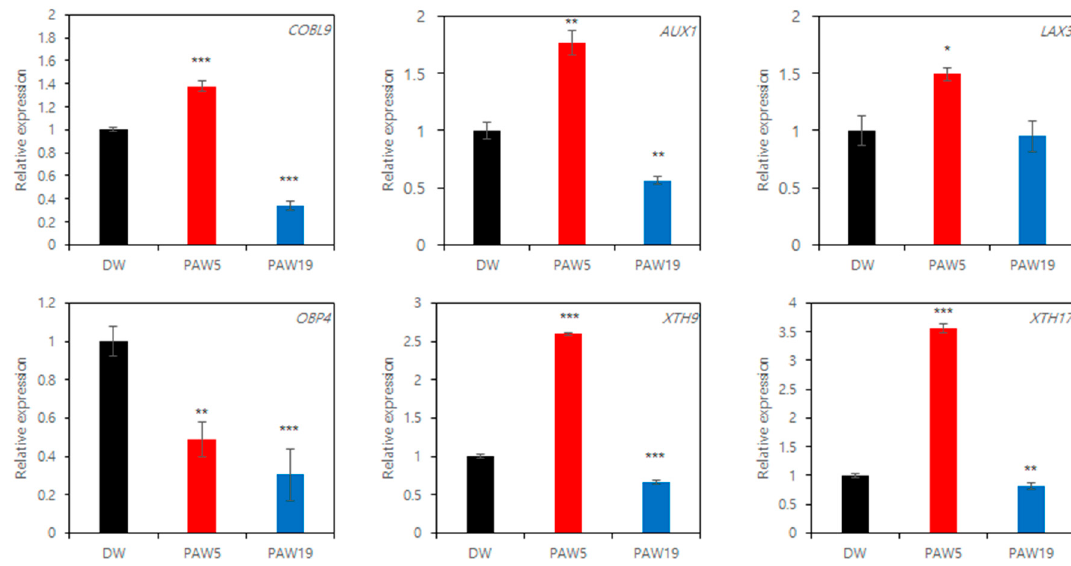
Figure 6. PAW treatment induces gene expression of root hair initiation and elongation genes in Arabidopsis . Student’s t -test compared with D.W. p < 0.05 *, p < 0.01 **, p < 0.001 ***.